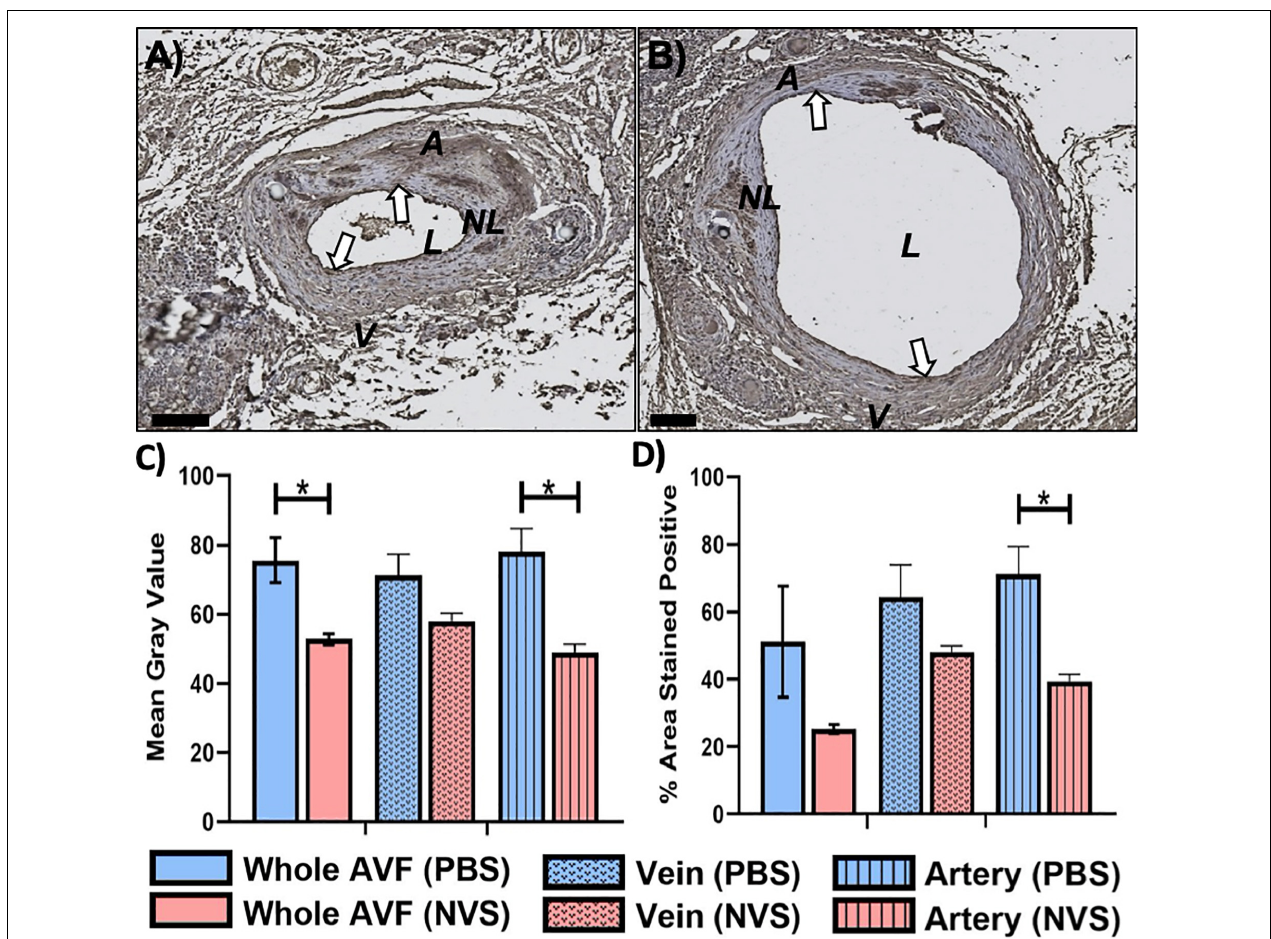
FIGURE 4 | IL-6 analysis. Representative immunohistochemistry images of IL-6 (A,B) staining of the AVF anastomoses at 4 weeks from animals treated with PBS (A) and NVS (B) . (C) Quantification of staining intensity (i.e., mean gray value). (D) Quantification of the percent area stained positive. Analyses were performed for the whole AVF, venous limb, and arterial limb. Results are presented as average ± standard error of mean. N = 3 per group. * p < 0.05. Scale bar = 100 µ m. A, arterial limb of AVF; V, venous limb of AVF; L, lumen; NL, neointimal lesion. White arrows indicate example regions of positive